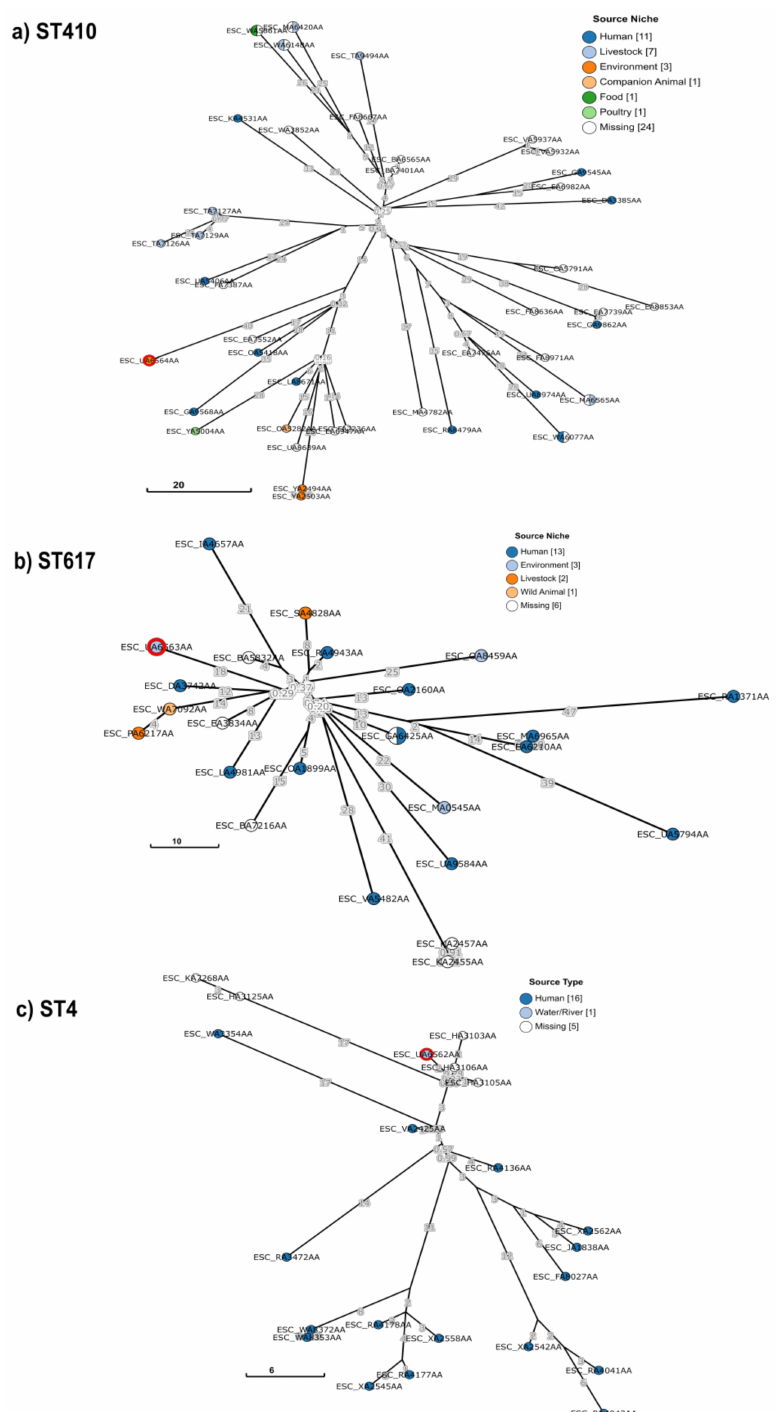
Figure 1. GrapeTree phylogenetic subtrees of the ST410, ST617, and ST4 lineages based on core- genome multilocus sequence typing (cgMLST) distances. The phylogeny was reconstructed using the rapid neighbor-joining (RapidNJ) algorithm and the core-genome MLST (cgMLST) V1 + Hierarchical Clustering (HierCC) V1 scheme from EnteroBase. E. coli isolates from this study are highlighted with a red circle. Isolate ID is indicated as the EnteroBase Barcode. The nodes are color-coded according to the isolation source niche as indicated in the key and the numbers in brackets represent the number of isolates. Scale bar indicates the number of cgMLST allelic